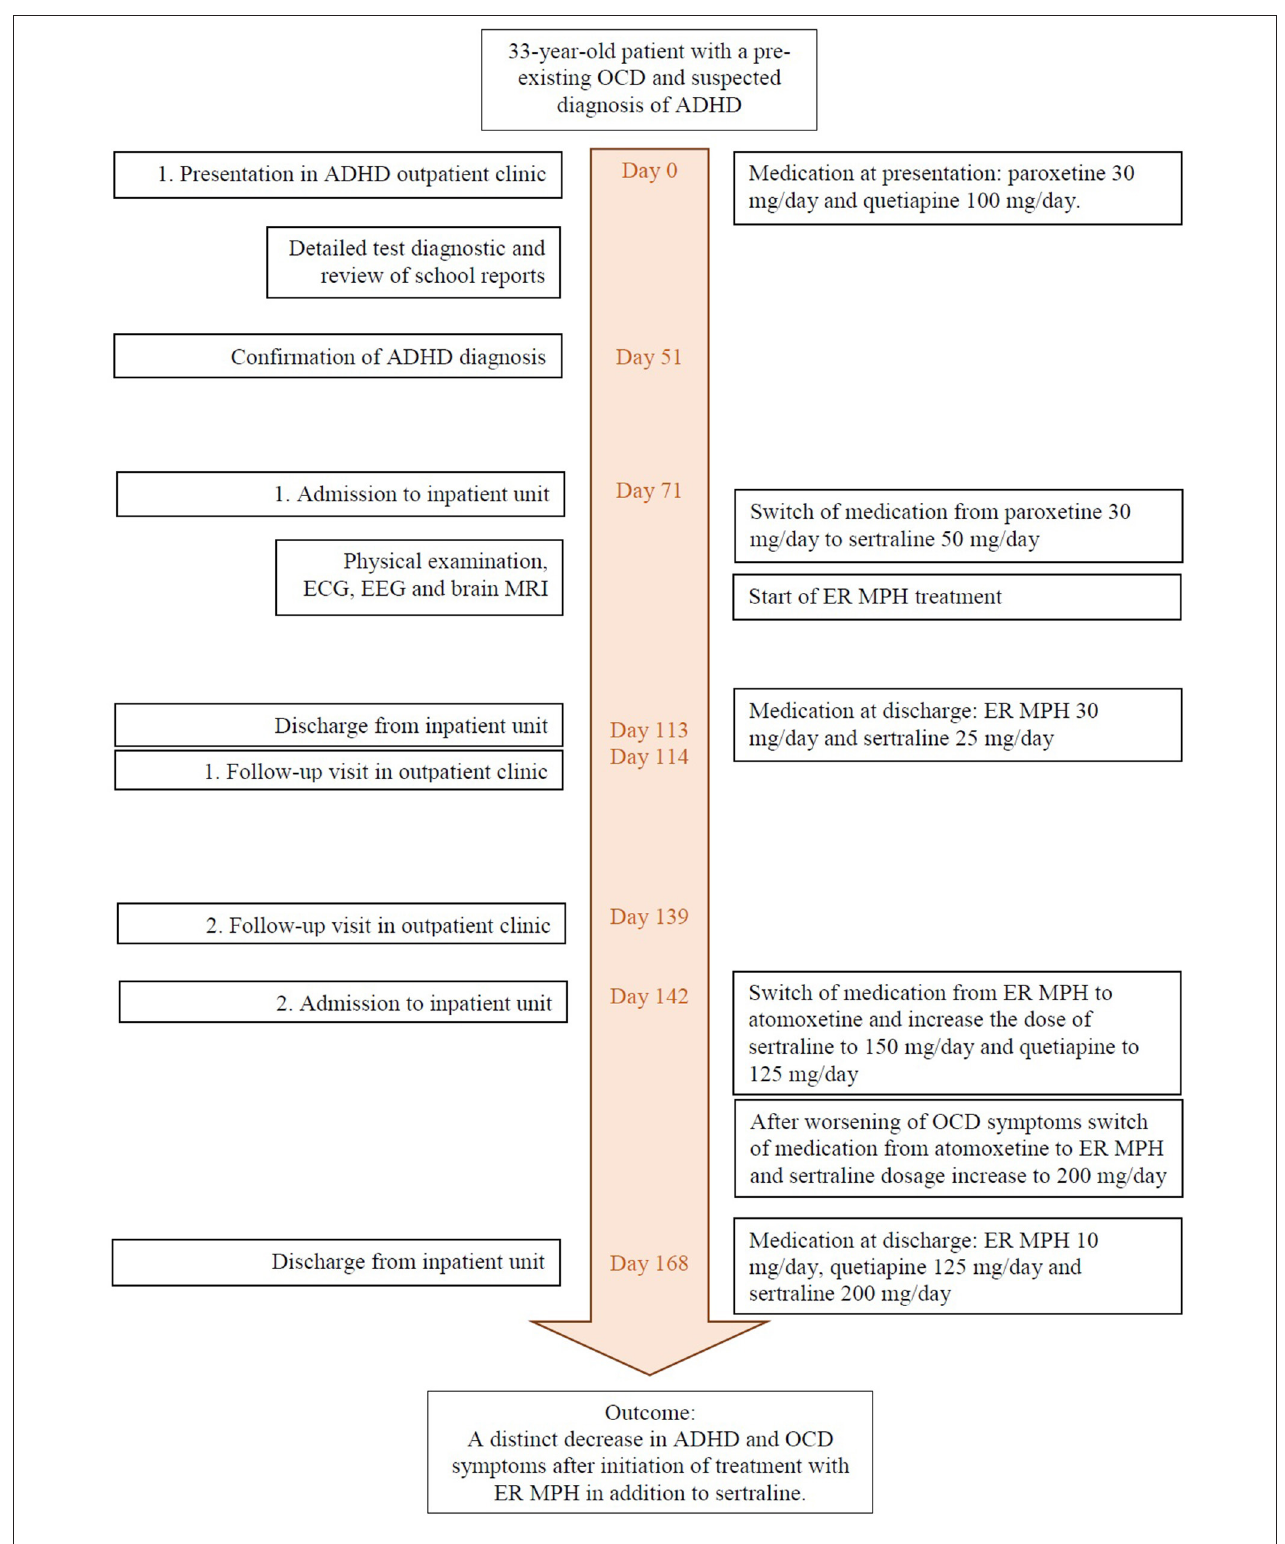
FIGURE 1 | Timeline of events and